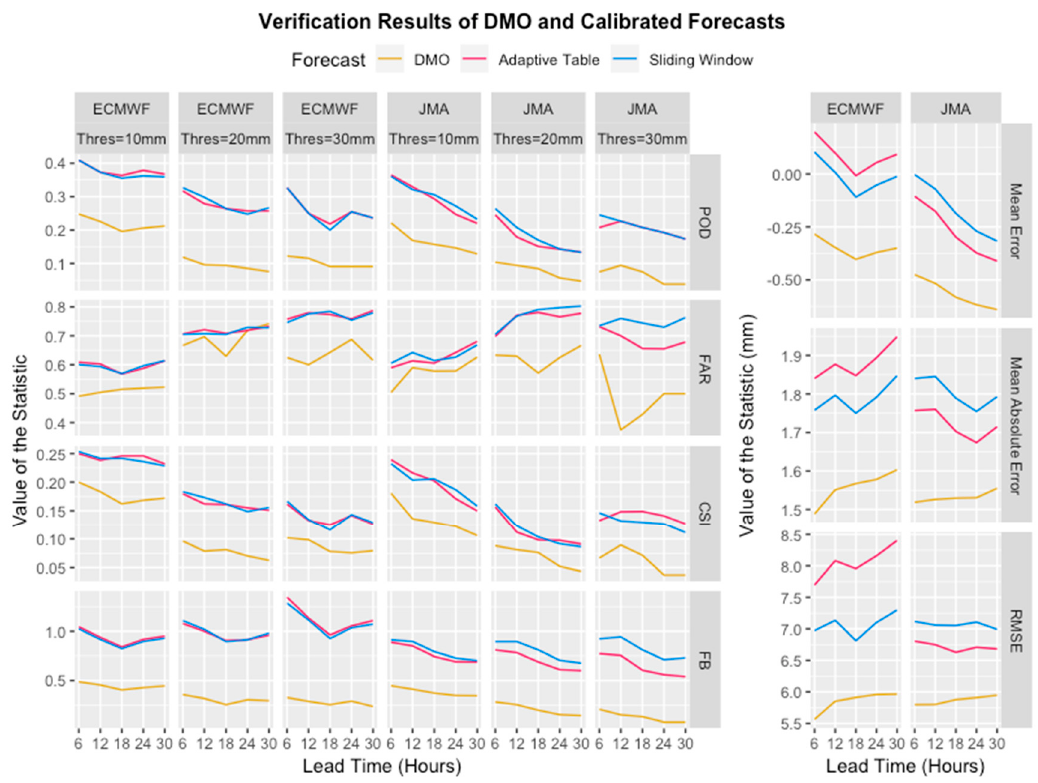
Figure 9. Verification results of DMO and calibrated forecasts: ( The set of panels on the left ) ( rows ) by using different metrics described in Section 2.4, ( columns ) for different models with different thresholds; ( The set of panels on the right ) ( rows ) by different error statistics, ( columns ) for different models.